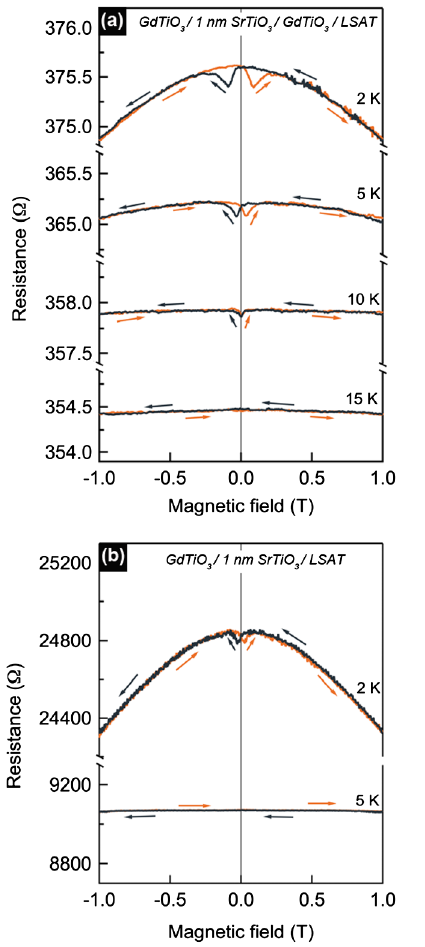
FIG. 1. (a) Magnetoresistance of a 4-nm GdTiO 3 = 1 - nm 4 - nm GdTiO LSAT heterostructure at 15 K, 10 K, SrTiO 3 = 3 = 5 K, and 2 K. Hysteresis appears below approximately 10 K in sweeps with increasing and decreasing B , respectively; see arrows. (b) Magnetoresistance of an 8-nm GdTiO 3 = 1 - nm LSAT heterostructure at 5 K and 2 SrTiO 3 =